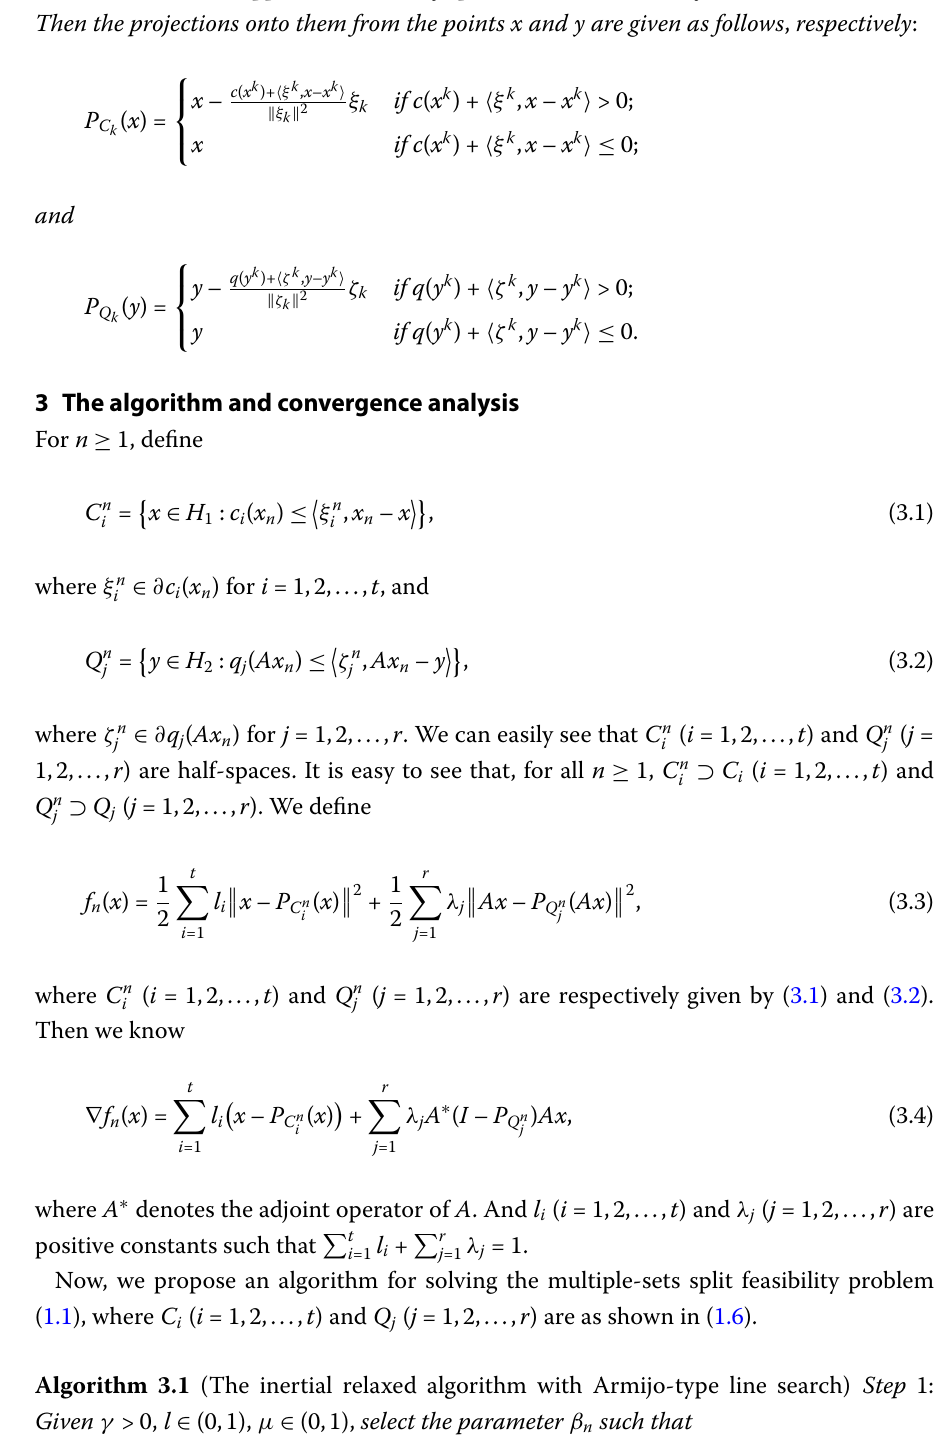
Algorithm 3.1 (The inertial relaxed algorithm with Armijo-type line search) Step